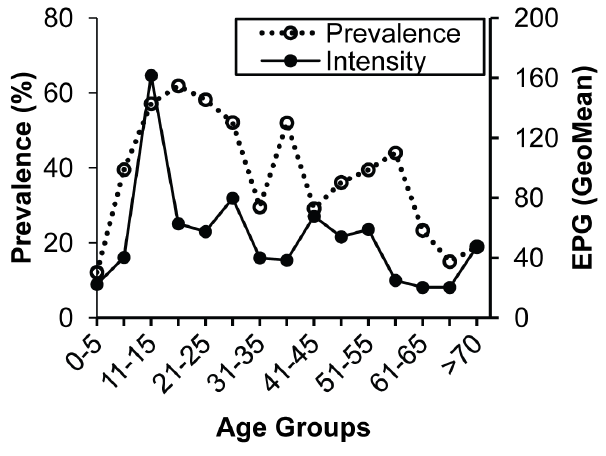
Figure 2. Age-related prevalence and intensity of infection. Prevalence (%) and intensity of infection (geometric mean epg) by age- group. epg - count of S. mansoni eggs per gram of stool. doi:10.1371/journal.pntd.0002572.g002 PLOS Neglected Tropical Diseases |